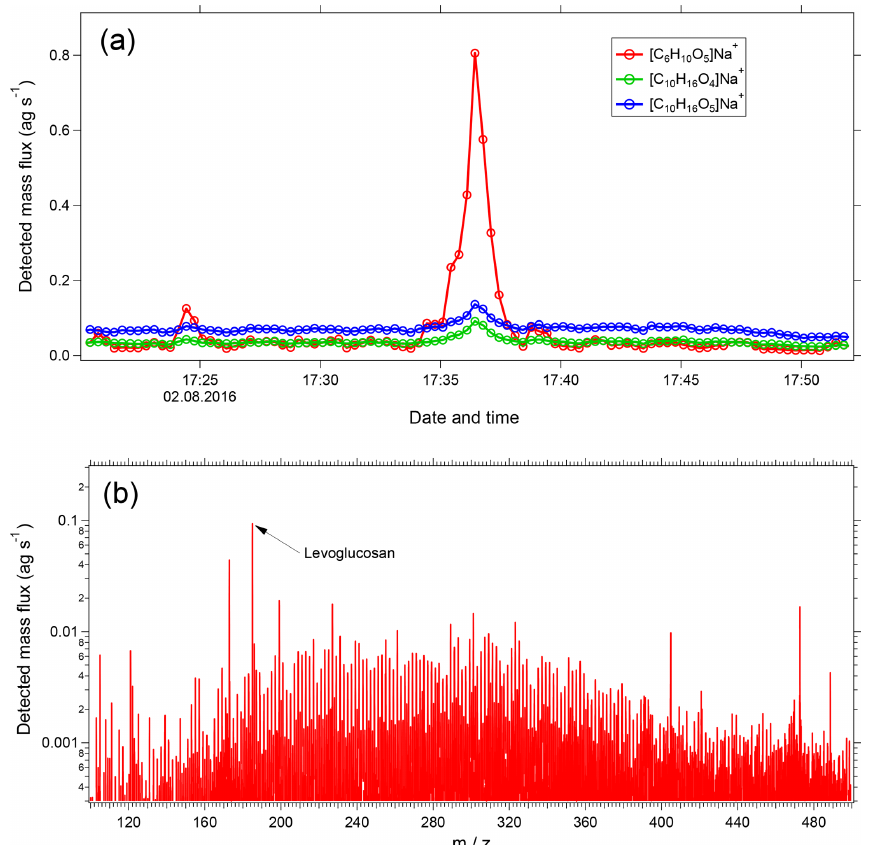
Figure 11. (a) Time series of selected ions showing transect of a wildfire plume. Shown are [ C 6 H 10 O 5 ] Na + (levoglucosan and its isomers) and the monoterpene SOA-influenced ions [ C 10 H 16 O 4 ] Na + and [ C 10 H 16 O 5 ] Na + . (b) Mass spectrum (20s average) during the peak of the wildfire plume with levoglucosan